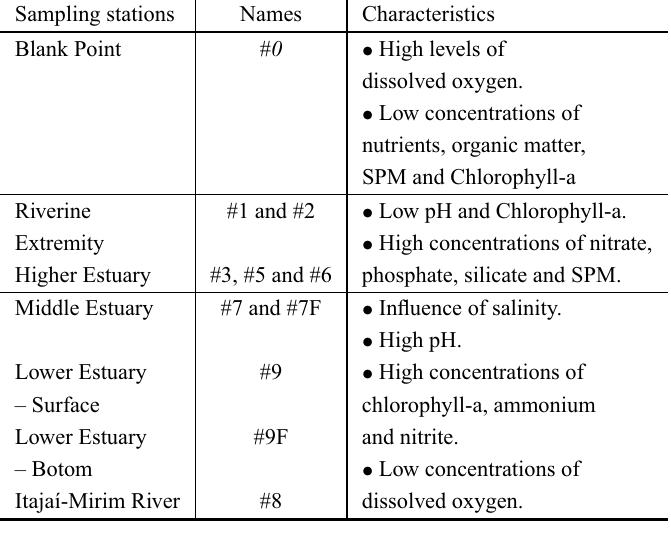
Main characteristics of the individual compartments by cluster analysis, and the stations included in each compartment.